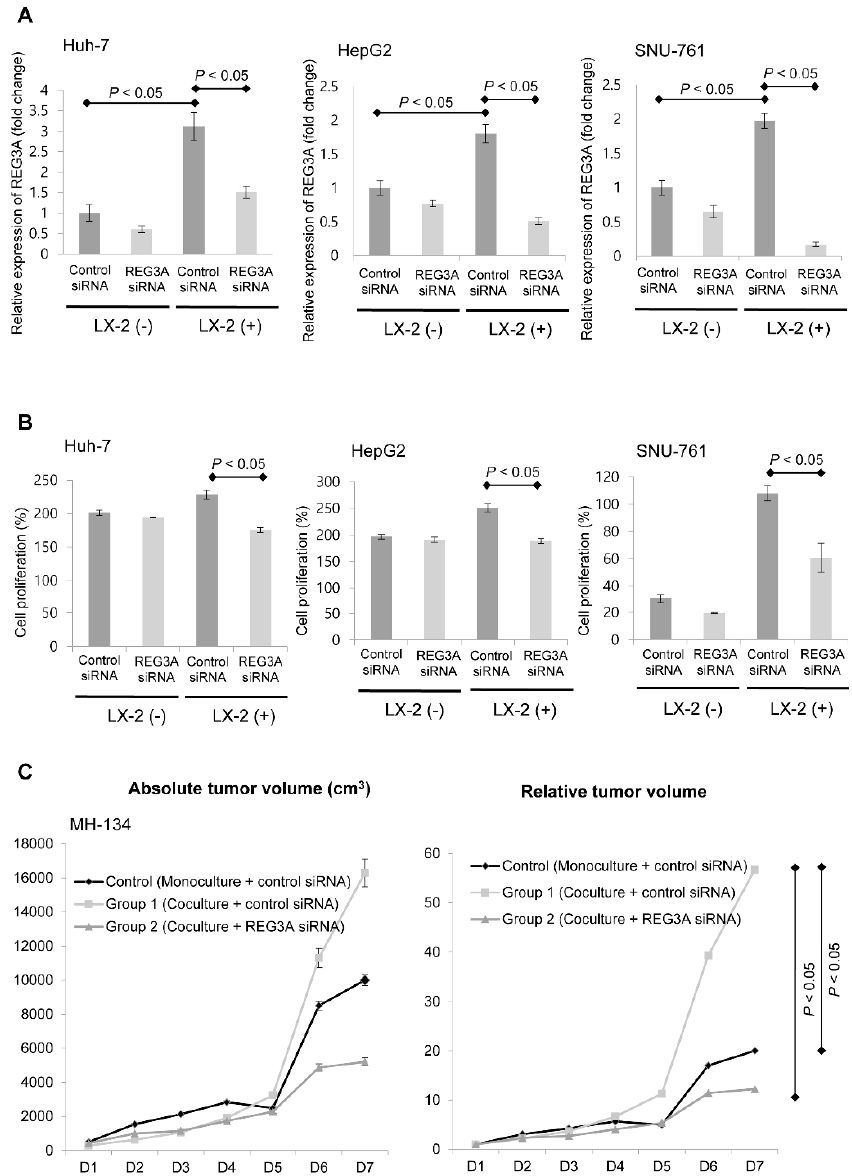
Figure 2. The effects of REG3A on proliferation of HCC cells cocultured with HSCs. ( A ) REG3A small interfering RNA (siRNA) transfection significantly suppressed REG3A mRNA expression as compared to control siRNA in HCC cells ( p < 0.05). Data are expressed as mean ± SD of percent changes of optical densities. The experiment was repeated three times. ( B ) When HCC cells were transfected with REG3A siRNA, the proliferation of HCC cells was significantly decreased compared with control siRNA transfection based on the 3-(4,5-dimethylthiazol-2-yl)-2,5-diphenyl tetrazolium bromide (MTT) assay results ( p < 0.05). Data are expressed as mean ± SD of percent changes of optical densities. The experiment was repeated three times. ( C ) Coculturing MH-134 cells with HSCs (Group 1) enhanced the proliferation of HCC cells compared with monoculturing MH-134 cells (Control) ( p < 0.05). REG3A siRNA attenuated in vivo HCC cell proliferation (Group 2) compared with control siRNA transfection (Group 1) ( p < 0.05). The data are expressed as mean ±